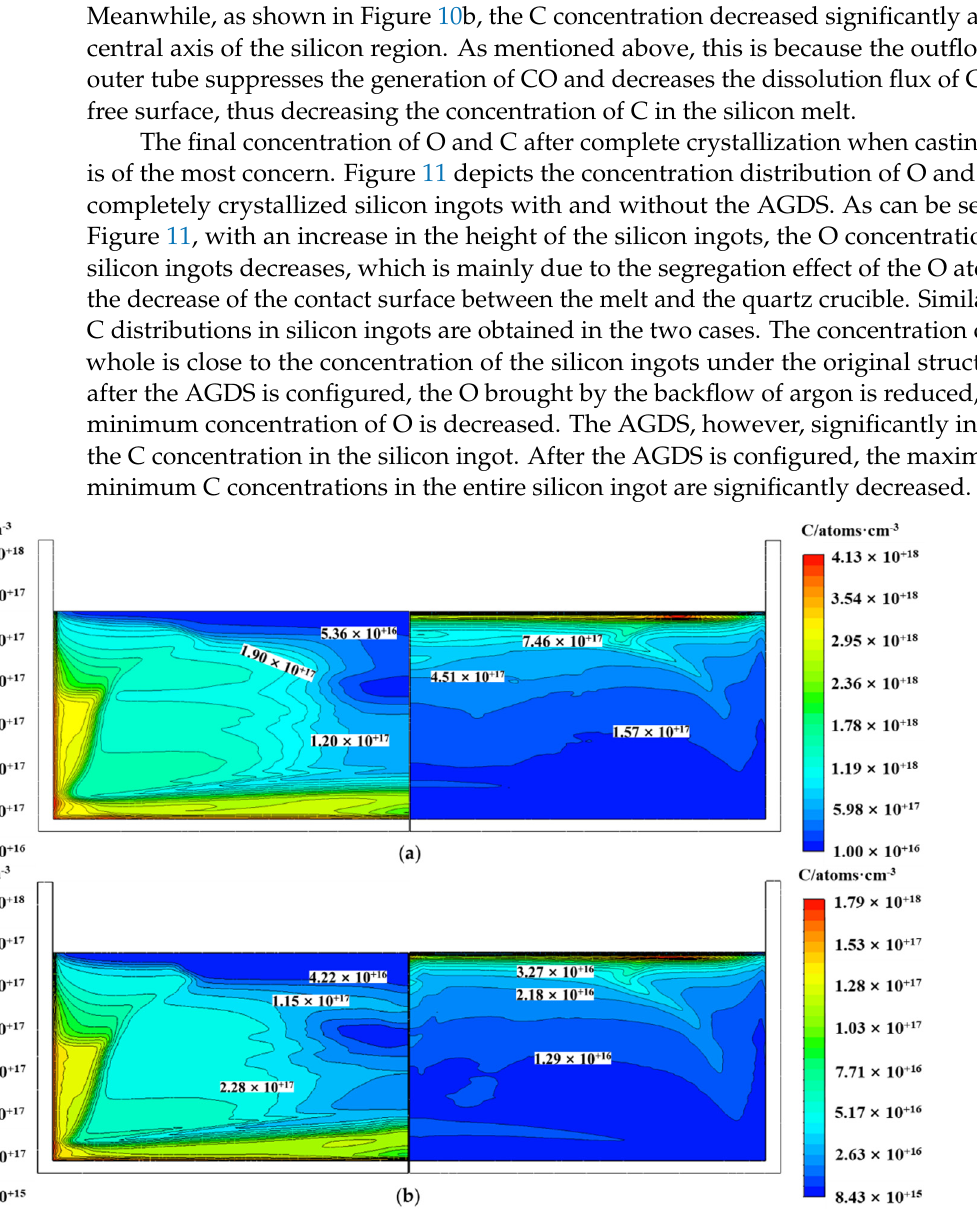
Figure 12. O ( a ) and C ( b ) concentration along the center axis of the silicon ingots. To clarify the influence on the change of the average O and C concentrations in the fully crystallized silicon ingot with and without the AGDS, the average O and C concen- trations of the radial cross-lines at different ingot heights were calculated respectively. The distribution of concentration along the height of the silicon ingot is shown in Figure 13. It can be seen that the radial average O concentration also gradually decreases with an increase in the height of the silicon ingot. On the one hand, this is because it is gradually